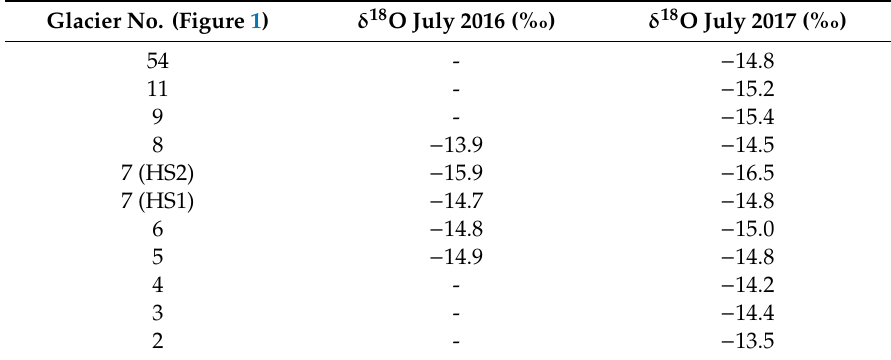
Table 1. The isotopic composition of melt water from the glaciers in July 2016 and July 2017. HS—Hydrological station.